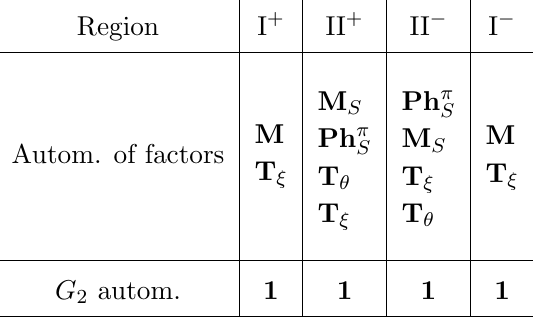
Table 1 . TCS mirror automorphism T 4 .